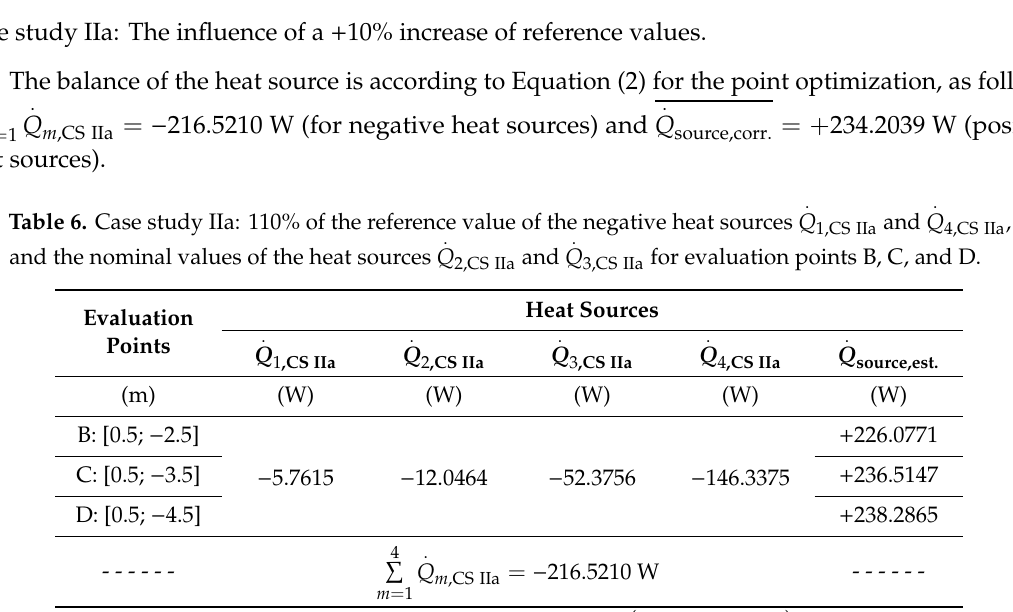
The number of samples: N = 684. Vector of constrained limits: L =